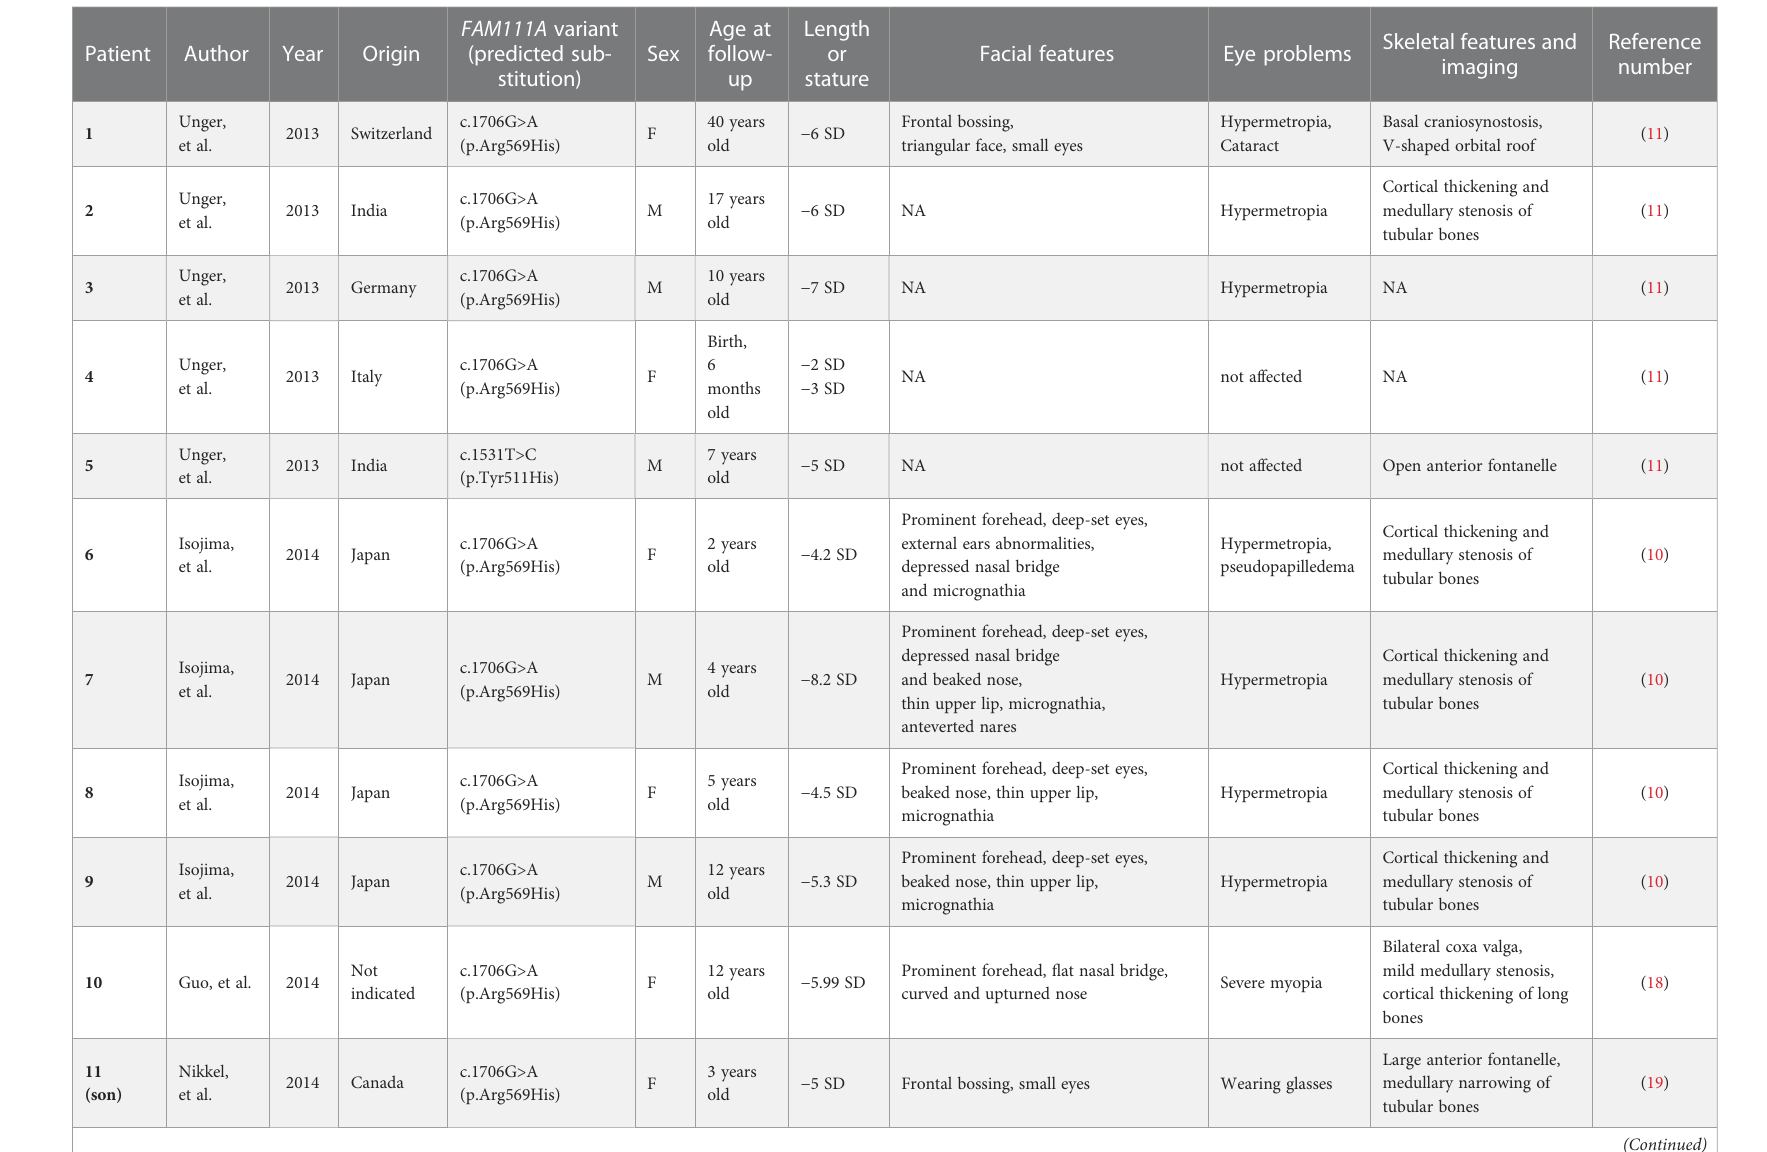
TABLE 1 Summary of clinical and radiological fi ndings in patients with KCS type